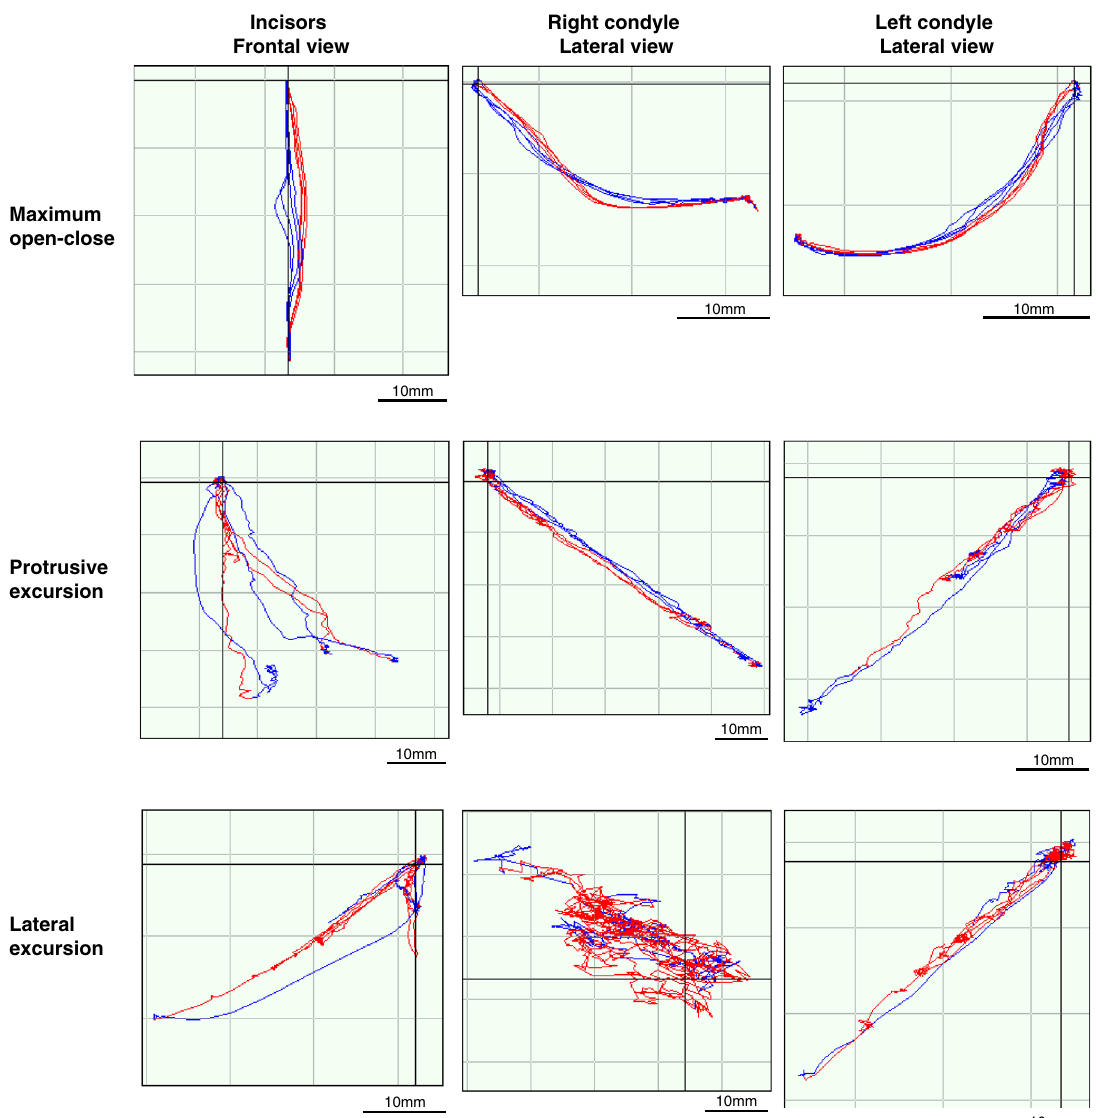
Figure 4. Pretreatment condylar movements and incisal paths as detected using a 6 degrees of freedom jaw movement recording system. Opening and closing, protrusive, and lateral jaw movements. The red line indicates the opening phase, and the blue line indicates the closing